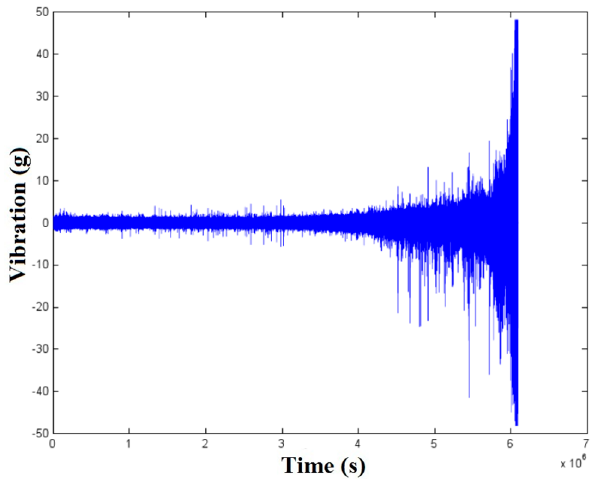
Figure 13. Vibration raw signal from a PRONOSTIA platform experiment [43].